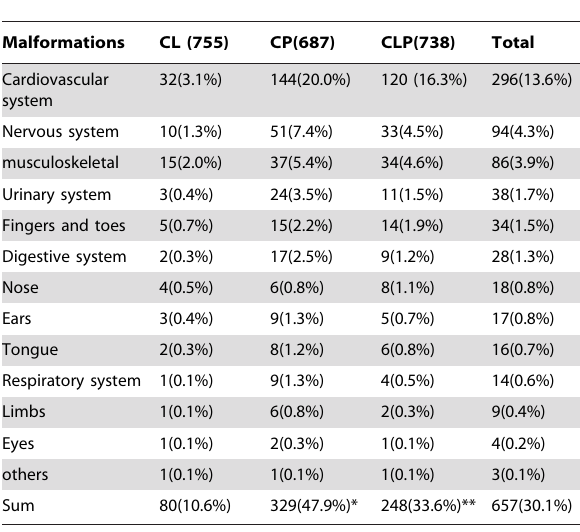
Table 4. The incidence of congenital heart disease in different type of